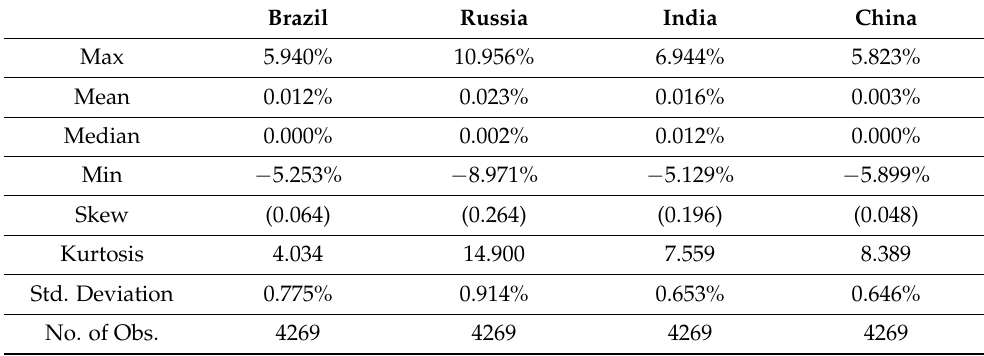
Table 1. BRIC Stock Market Summary